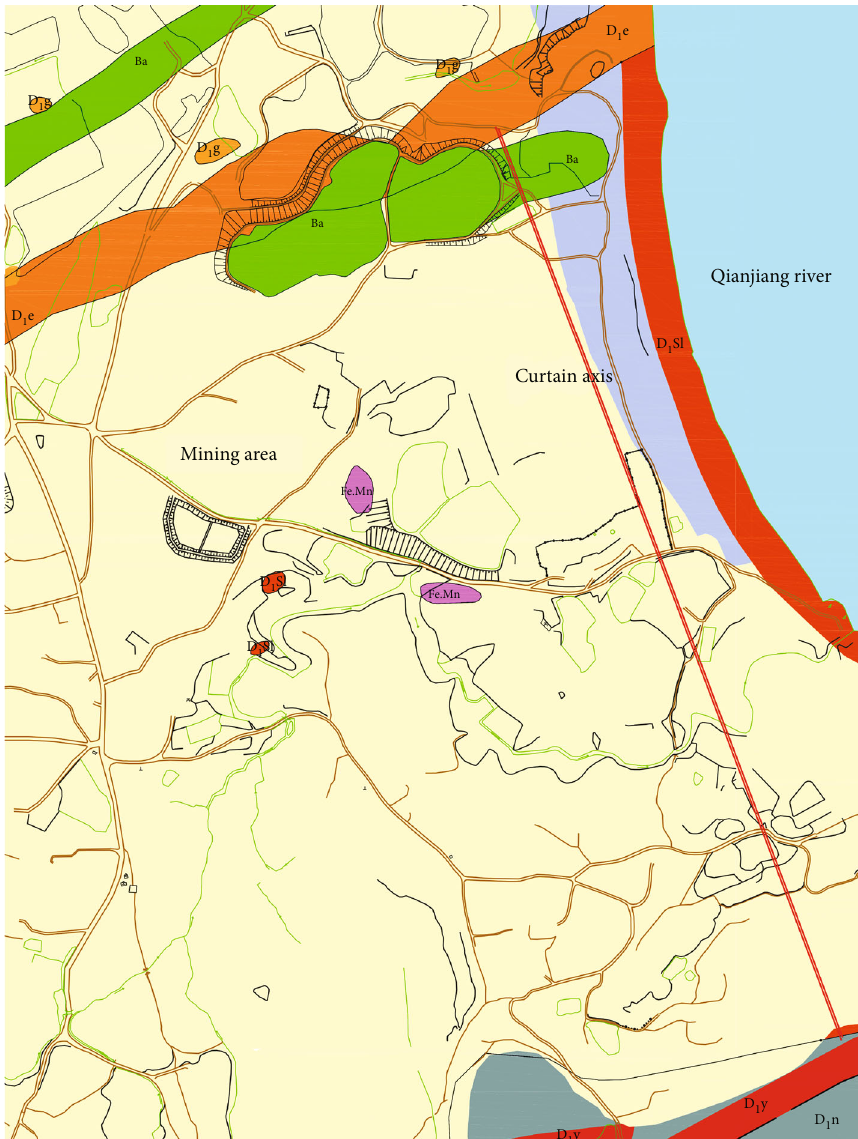
Figure 3: The plane position of the axis of the antiseepage